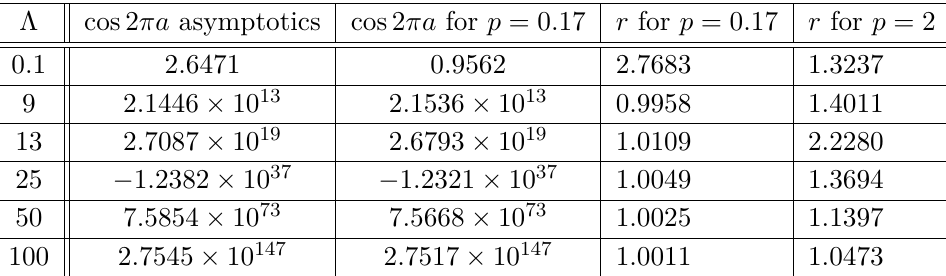
Table 2. Here the large asymptotic behavior (3.32) for the A-cycle is checked through numerical calculations. The ratio of the asymptotic and numerical values of cos 2 πa is denoted by r . It approaches to 1 for large instanton counting